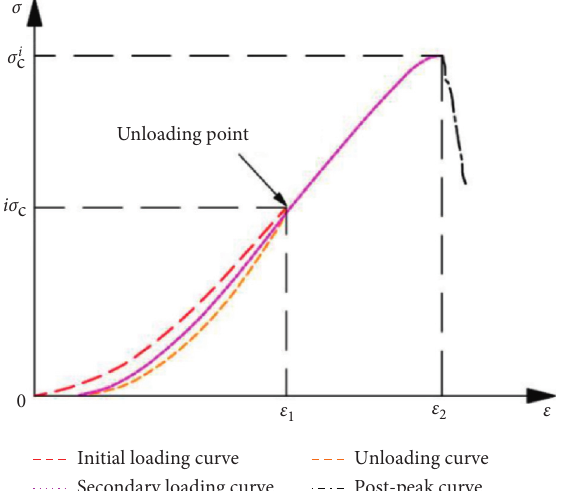
Figure 3. All the curves were in favourable consistency and